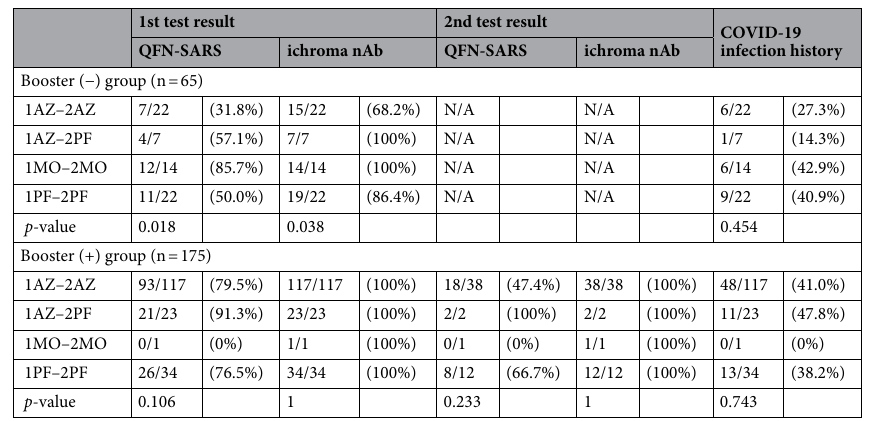
Table 2. The results of QFN-SARS and ichroma nAb and infection history of COVID-19 with respect to the type of vaccination. p -values were calculated by two-sided chi square test with post-hoc analysis. AZ AstraZeneca COVID-19 Vaccine, ichroma nAb ichroma™ COVID-19 nAb assay, MO Moderna COVID-19 Vaccine, N/A not applicable, PF Pfizer-BioNTech COVID-19 vaccine, QFN-SARS QuantiFERON-TB SARS- CoV-2 ELISA Kit.